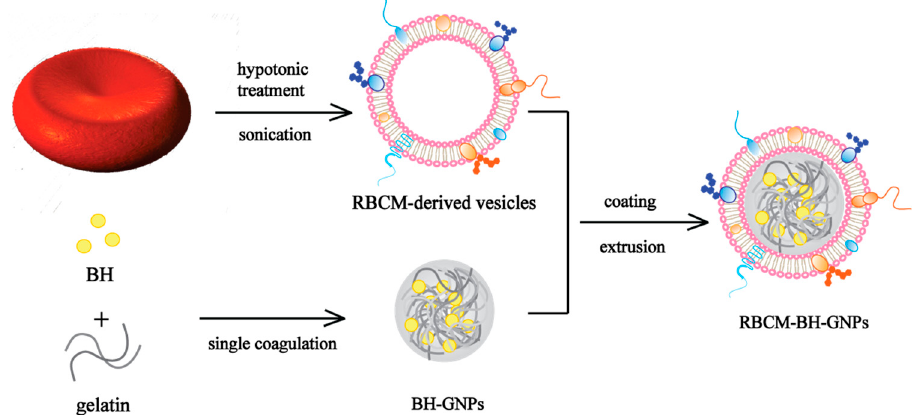
Figure 1. Schematics of preparation process of the erythrocyte membrane-camouflaged berberine hydrochloride-loaded gelatin nanoparticle (RBGP) system. RBCM: red blood cell membrane; BH: berberine hydrochloride; BH-GNPs: BH-loaded gelatin nanoparticles.